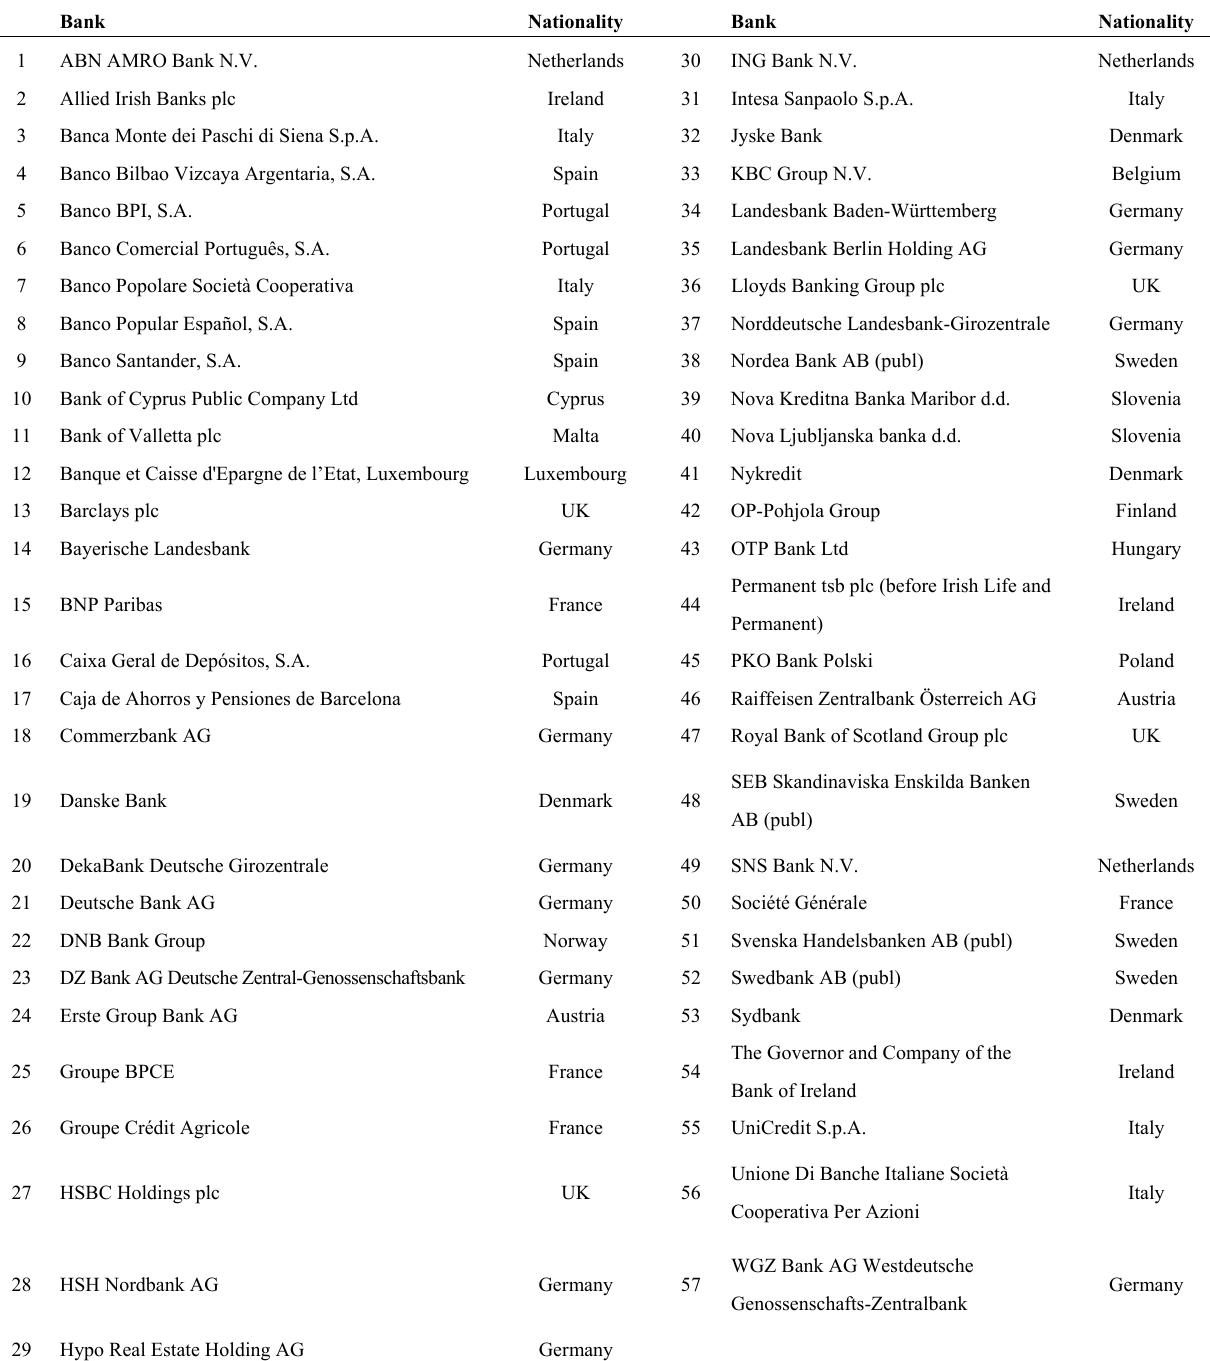
Table A1. List of Banks assessed as the Bank-sovereign